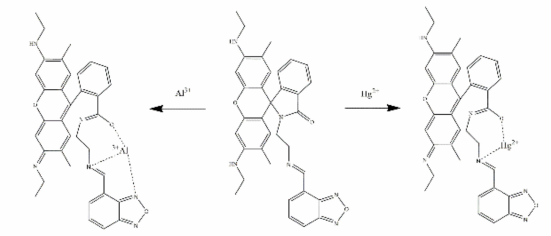
Figure 55. The possible sensing mechanism of RBO (Table 4, No. 6) for Al 3+ and Hg 2+ [111]. Chan W. C., et al. reported a novel rhodamine-based sensor, R34 (Table 4, No. 7), syn- thesized by the reaction of rhodamine B hydrazide and 3,4- dihydroxybenzaldehyde [112]. R34 exhibited a sensitive and selective response to Al 3+ and Cu 2+ and displayed significant color change from colorless to pink and colorless to orange for Al 3+ and Cu 2+ , respectively (Figure 56). The prepared sensor was successfully used in actual water samples and living cells